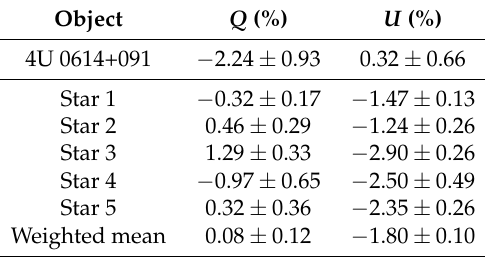
Figure 1. Left panel: U vs. Q for the averaged image of the optical r filter, for 4U 0614+091 (blue triangle) and for five reference field stars (black squares), Table 1. With a red dot we indicated the weighted mean of the reference stars Stokes parameters. The parameters reported are not corrected for interstellar or instrumental effects. Right panel: Spectral energy distribution of the system 4U 0614+091 built starting from the radio (green triangles) and infrared points (blue squares) of [4], from the ALL WISE catalog magnitudes (red circles) and from the r -flux obtained in this work (black x). With an orange arrow we indicated the W3-band WISE upper limit obtained from the ALLWise catalog. Superimposed, the two linear fits of the spectral energy distribution (SED). All the points are normalized to the fluxes of [4]. Table 1. Values of the Q and U Stokes parameters not corrected for interstellar or instrumental effects represented in Figure 1 (left panel) for 4U 0614+091 and for five reference field stars. The weighted mean of the reference stars Stokes parameters has been reported in the last row and corresponds to the amount of correction that we applied to Q and U of the